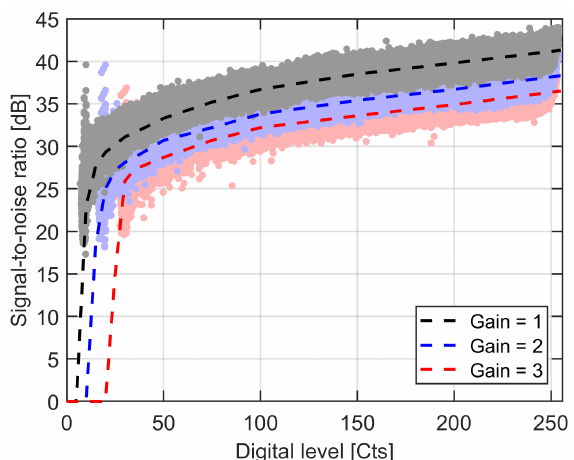
Figure 6. Signal-to-noise ratio as a function of digital intensity for the camera at various gain settings. The data points have been calculated from Equation (2), and the dashed-line profiles represent the mean of the scatter